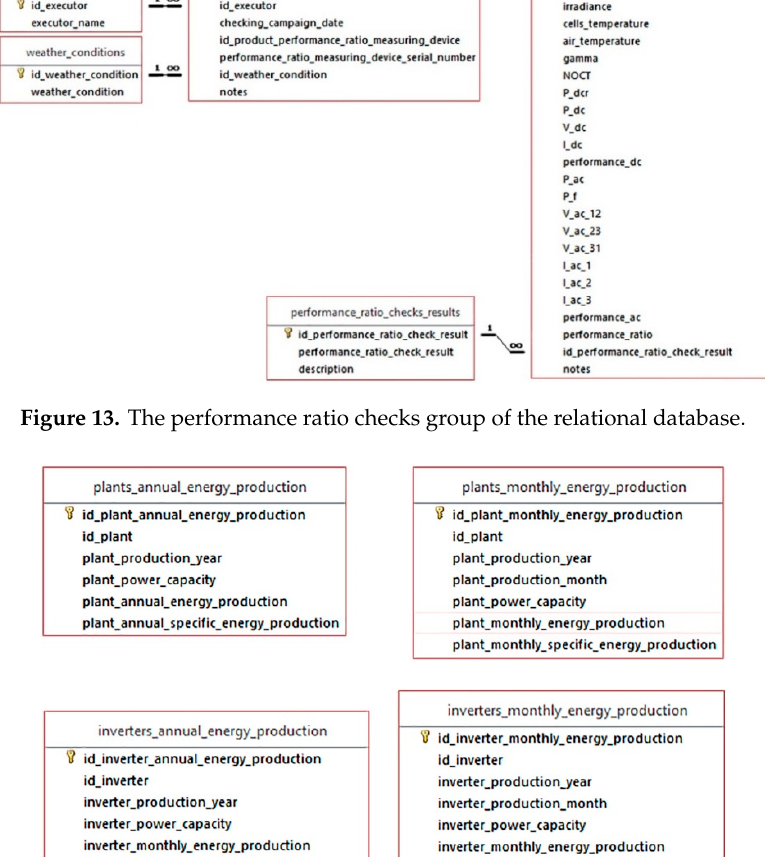
Figure 14. The energy production data group of the relational database.